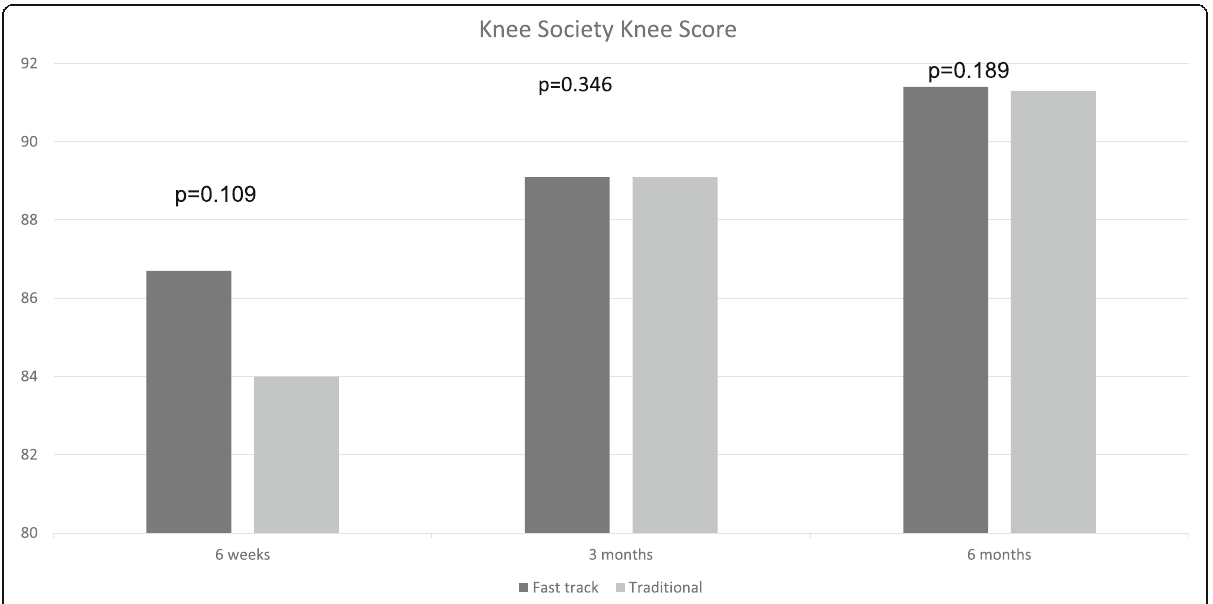
Fig. 3 KSKS of fast track group compared to traditional rehabilitation group at various time points